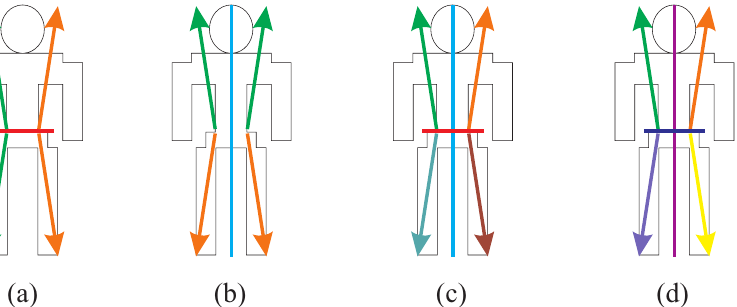
Figure 4. Graphic templates of different types of planar symmetry used in the UGVA images: ( a ) bilateral vertical axial symmetry (type α ), ( b ) bilateral horizontal axial symmetry (type β ), ( c ) combined axial symmetry (type λ ), ( d ) radial symmetry (type δ